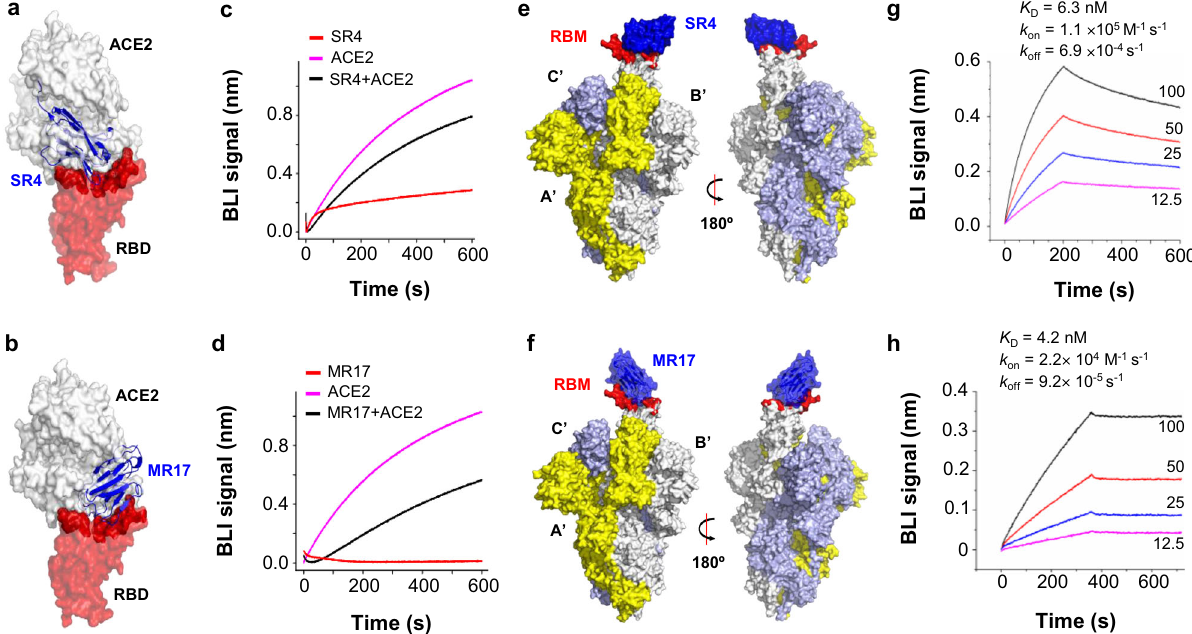
Fig. 2 Molecular basis for neutralization. a , b Alignment of the SR4-RBD ( a ) or MR17-RBD ( b ) to the ACE2-RBD structure (PDB ID 6M0J) 3 reveals that SR4/MR17 (blue) binds RBD (red) at the motif (dark red) where ACE2 (white) also binds. c , d SR4 ( c ) and MR17 ( d ) compete with ACE2 for RBD binding. A sensor coated with streptavidin was saturated with 2 μ g mL − 1 of biotinylated RBD. The sensor was then soaked in 200 nM of the indicated sybody before further soaked in sybody-containing buffer with (black) or without (red) 25 nM of ACE2 for BLI signal recording. As a control, the ACE2 – RBD interaction was monitored in the absence of sybodies (magenta). e , f Alignment of the SR4-RBD ( e ) and MR17-RBD ( f ) to the “ up ” conformation of the RBD from the cryo-EM structure of the trimer S (PDB ID 6VYB) 2 . The three subunits are colored yellow (A ’ ), white (B ’ ), and light blue (C ’ ). Synthetic nanobodies are colored deep blue. RBM (red) marks the ACE2-binding motif. g , h Binding kinetics of SR4 ( g ) and MR17 ( h ) to S. BLI assay was performed with sybodies immobilized and S as analyte at the indicated concentrations (nM). Source data for c , d , g , h are provided as a Source data fi le. ACE2